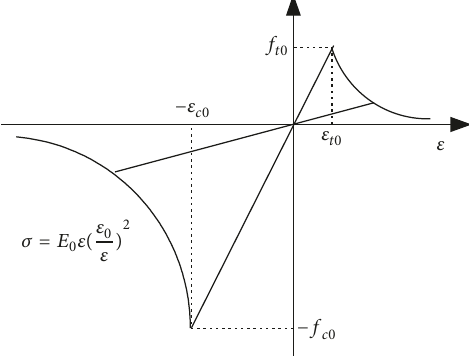
Figure 2: The constitutive law of